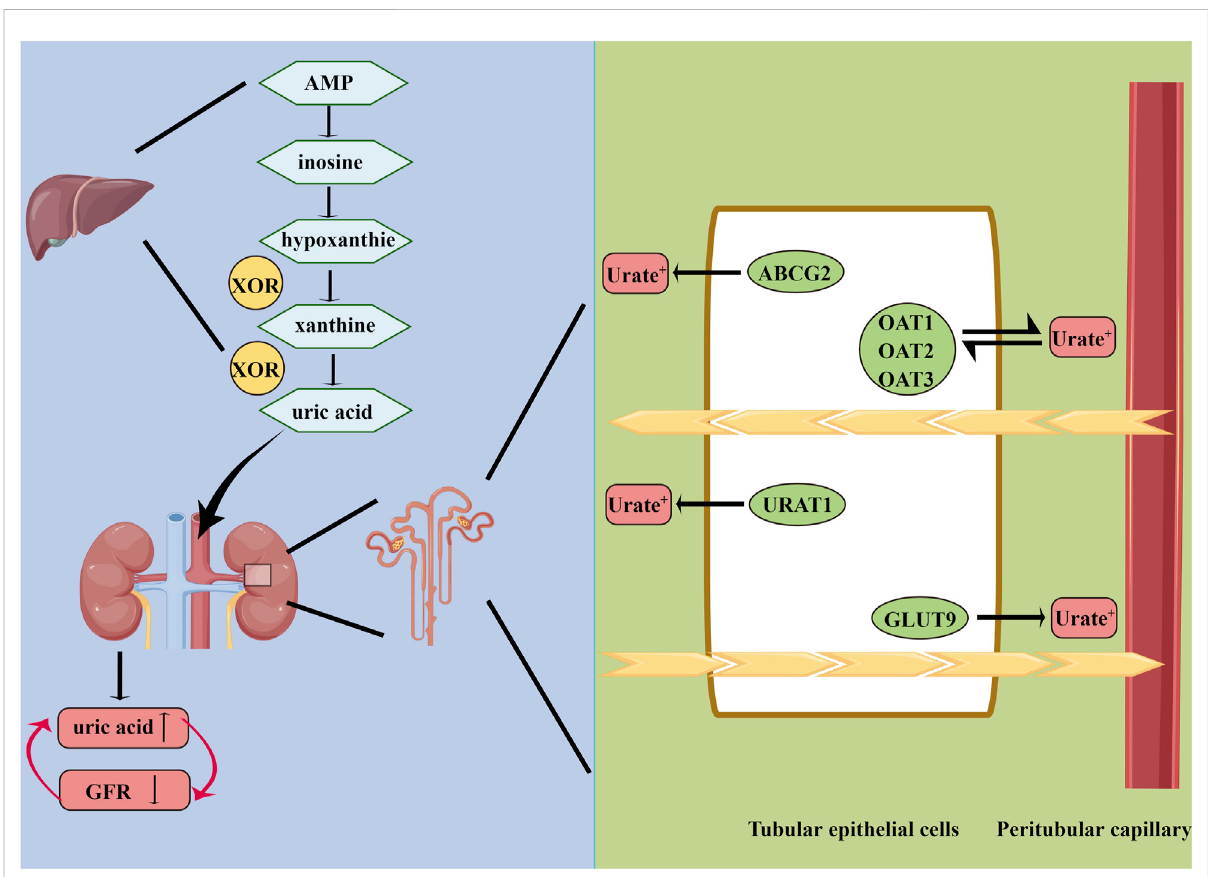
FIGURE 1 Summary of uric acid metabolism. AMP, adenosine monophosphate; XOR, xanthine oxidoreductase; GLUT9, glucose transporter 9; OAT1, organic anion transporter 1; ABCG2, ATP-binding cassette superfamily G member 2; URAT1, urate anion transporter 1; OAT3, organic anion transporter 3; GFR, glomerular fi ltration